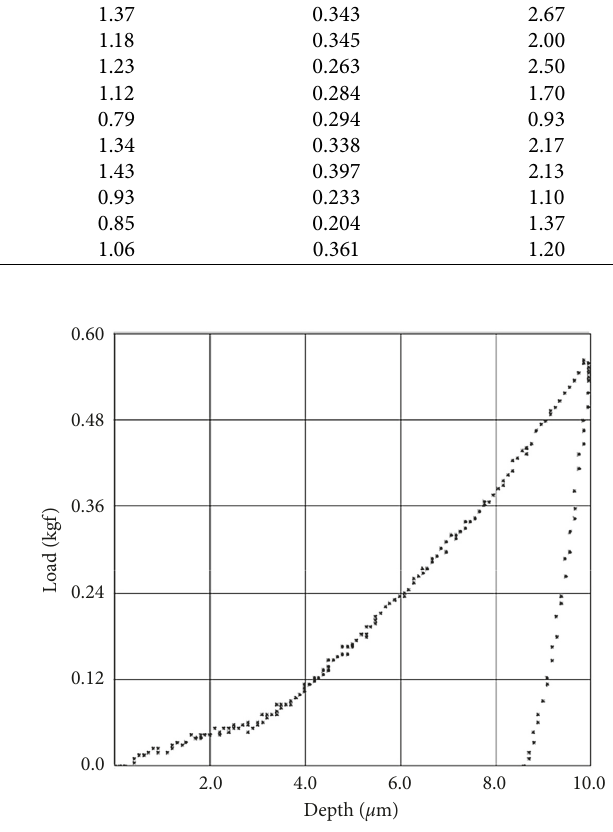
Figure 7: Nanoindentation force curves by penetration depth.